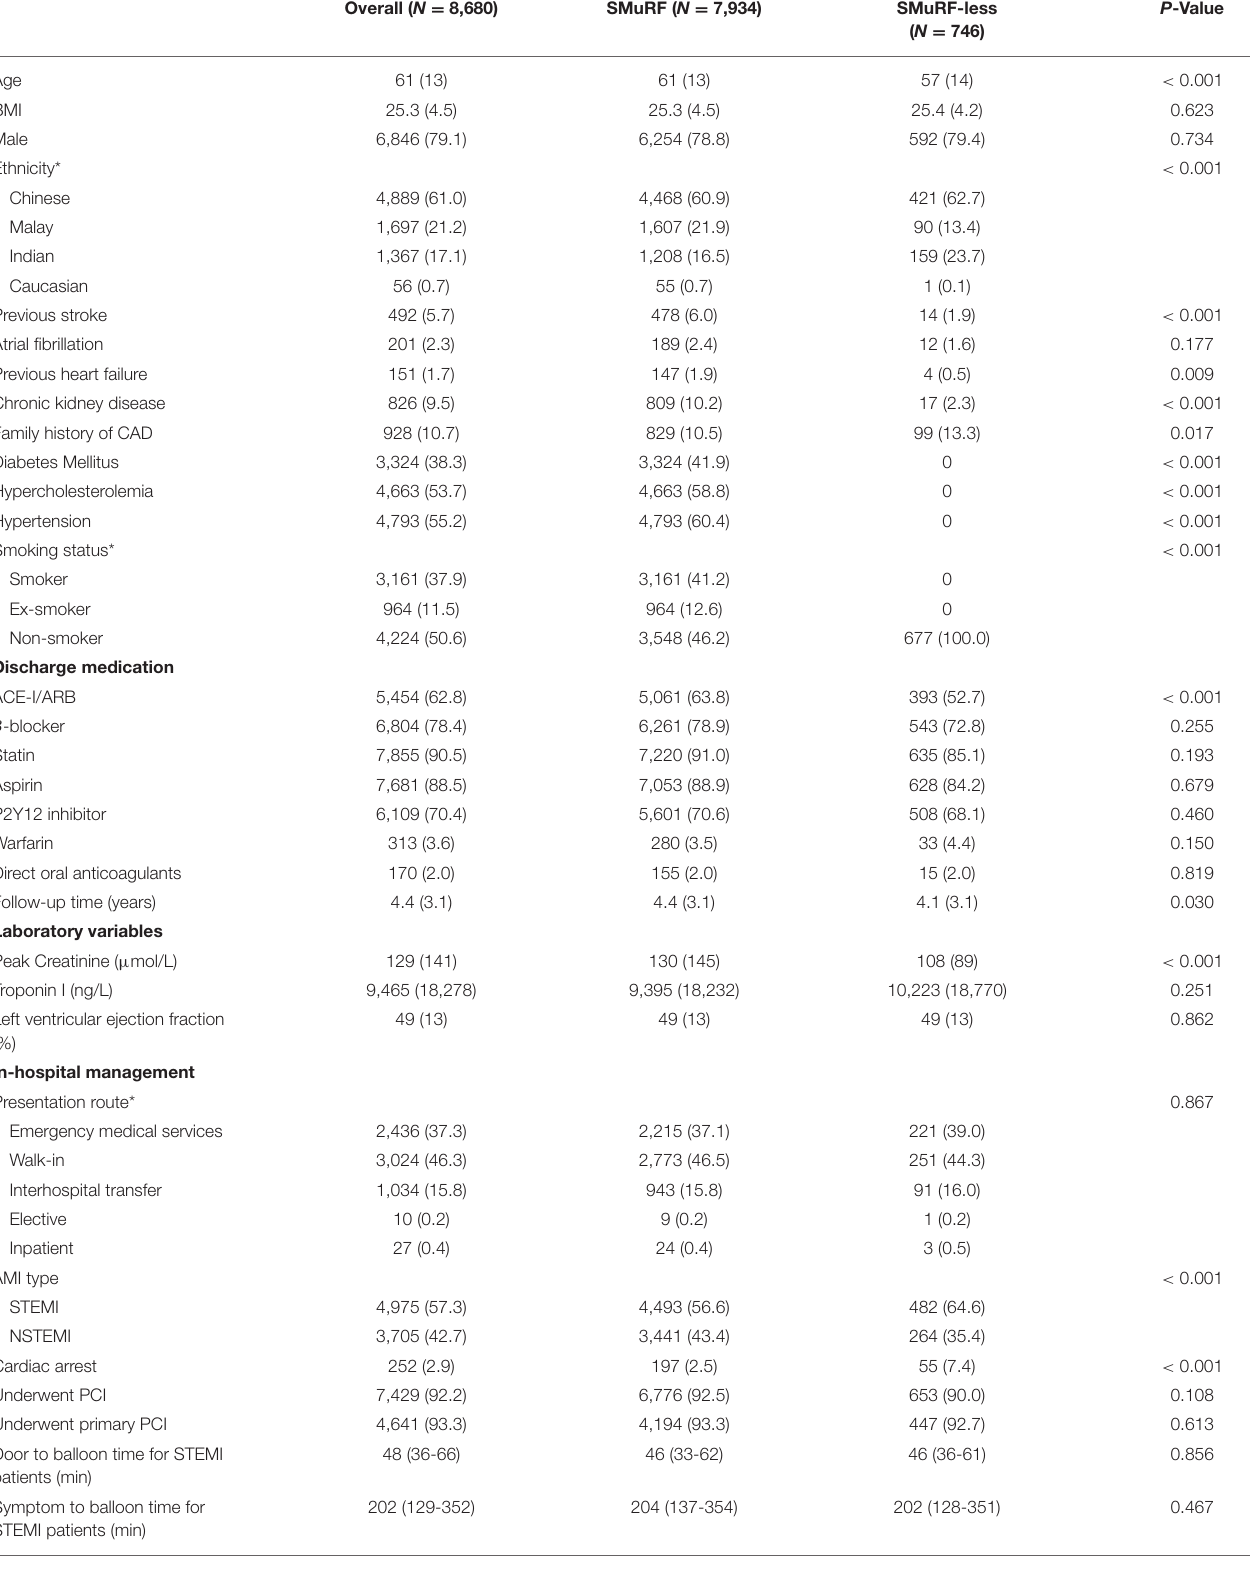
TABLE 1 | Demographic and clinical characteristics of study cohort presenting with acute myocardial infarction, based on standard modifiable cardiovascular risk factors. Overall ( N =